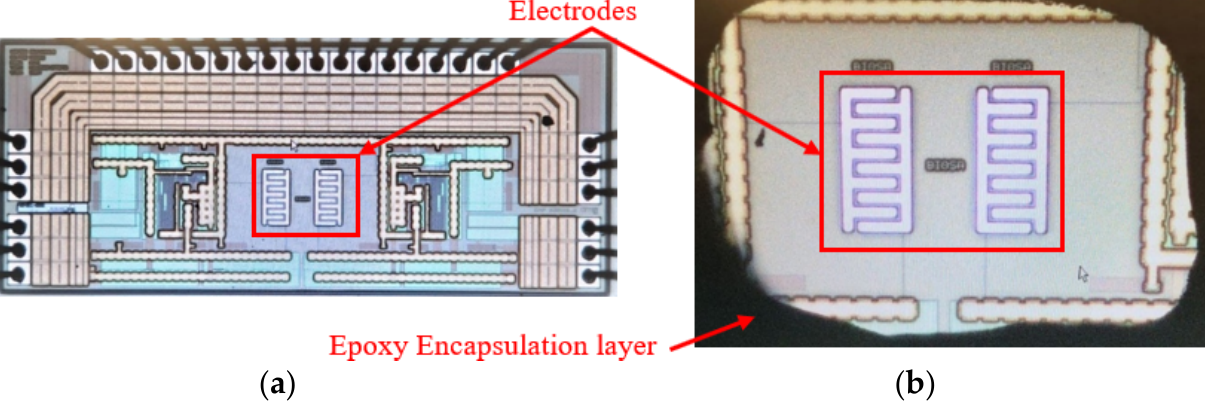
Figure 15. ( a ) Die Micrograph without encapsulation, ( b ) the chamber created after partial encapsu- lation of the chip.